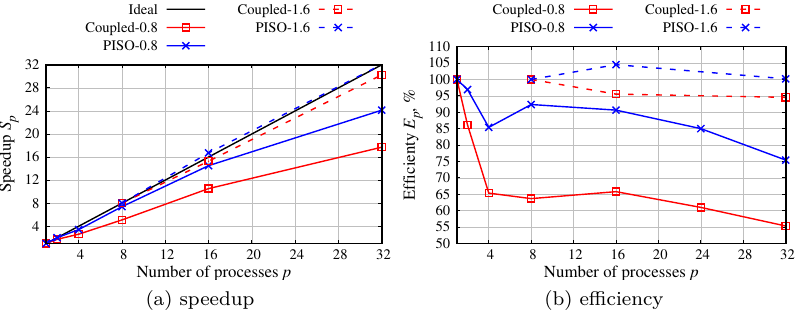
Figure 5. Strong scalability of parallel algorithms based on the coupled and PISO schemes solving the considered problem on meshes with 0.8 and 1.6 million